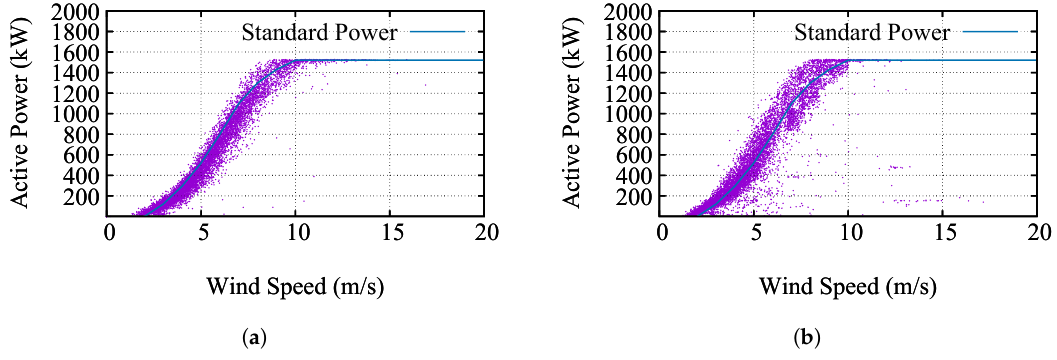
Figure 2. Power curves of a wind turbine in a normal condition ( a ) and a developing fault condition ( b ) with the same sampling